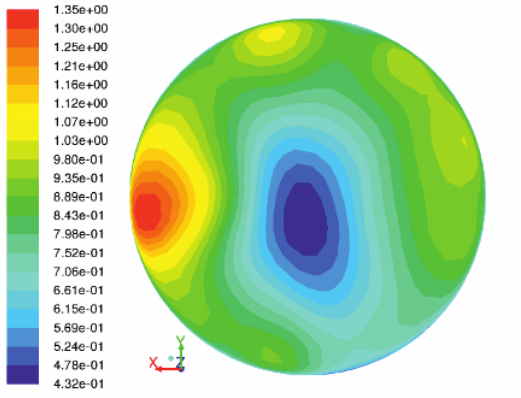
Figure 19: Deviation of velocity in metering run #1